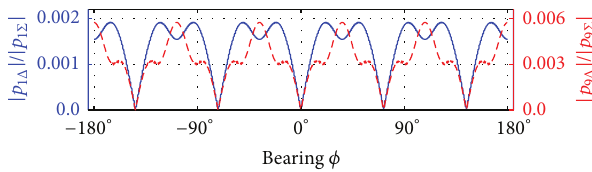
Figure 5: Approximating (25) by (26) is validated by the small error ratio |𝑝 𝑛Δ |/|𝑝 𝑛Σ | shown here for 𝑛 = 1 (solid curve) and 𝑛 = 9 (dashed curve).